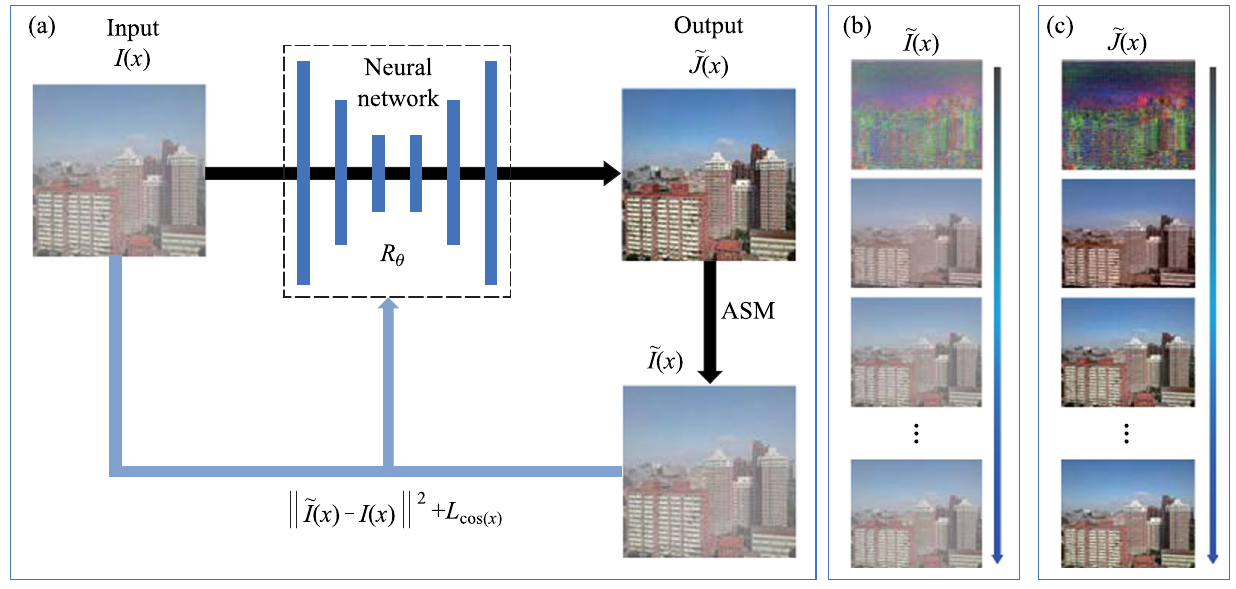
Fig. 1 Principle and architecture diagram of the SZDNet. a A hazy image I ( x ) is fed into the neural network, and a dehazed image ̃ J ( x ) is output after processing by the neural network, which is numerically treated to simulate the hazy image generation processes through the ASM to gener- ̃ I ( x ) ate .We use the sum of the MSE and the cosine distance ( L cos ( x ) ) between I ( x ) and ̃ I ( x ) neural network. b Evolution of during the optimization process. c Evolution of